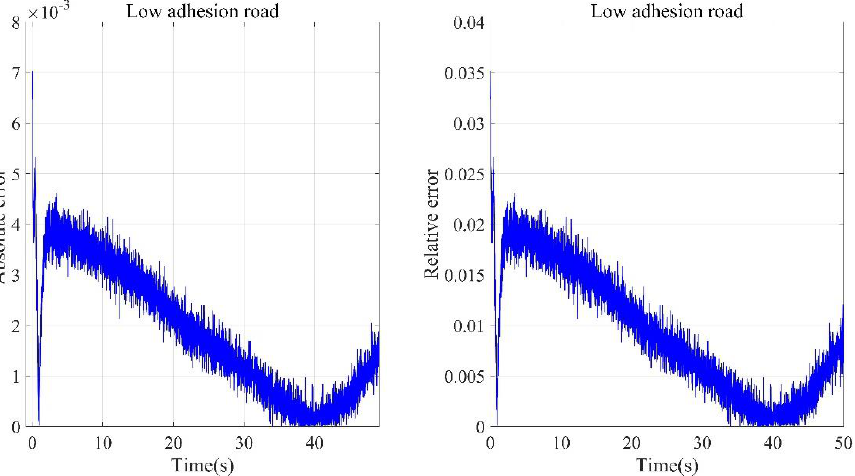
Figure 22. Error analysis of road adhesion coefficient estimation result under low-adhesion road.